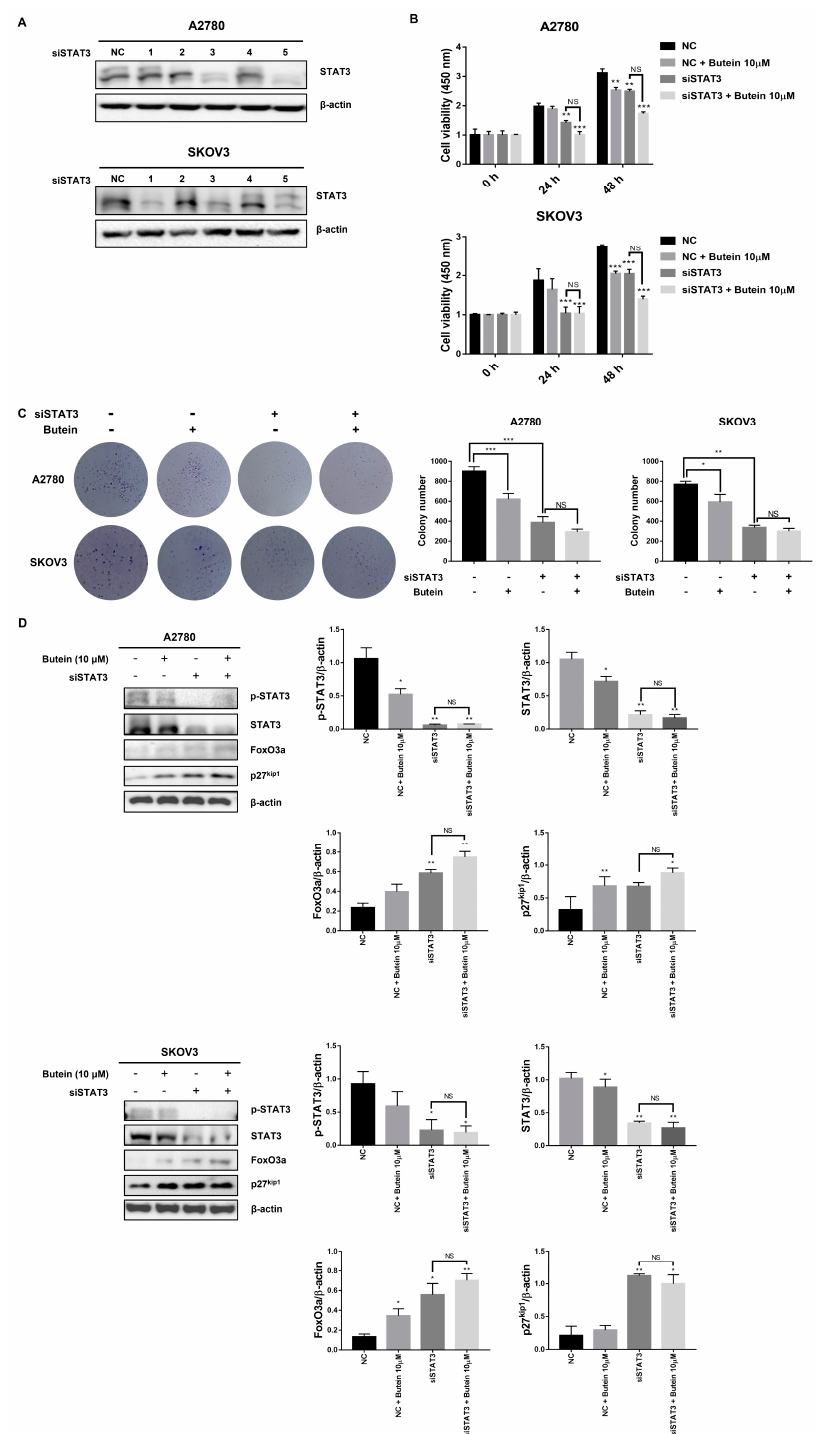
Figure 6. Butein increased protein expression of FoxO3a and p27 kip1 through inactivation of STAT3. ( A ) Western blot showing STAT3 protein expression following siSTAT3 treatment. β -actin was used as a loading control. ( B ) Cell proliferation upon butein and siSTAT3 treatment was detected through the CCK-8 assay (** p < 0.01 and *** p < 0.001; NS, not significant). ( C ) Cell growth following butein and siSTAT3 treatment was detected by colony formation assay (* p < 0.05, ** p < 0.01, and *** p < 0.001; NS, not significant). Data represent the mean ± SD of three replicates. ( D ) Expression levels of STAT3, FoxO3a, and p27 kip1 proteins in ovarian cancer cells with the combination of butein and siSTAT3 treatment. β -actin was used as a loading